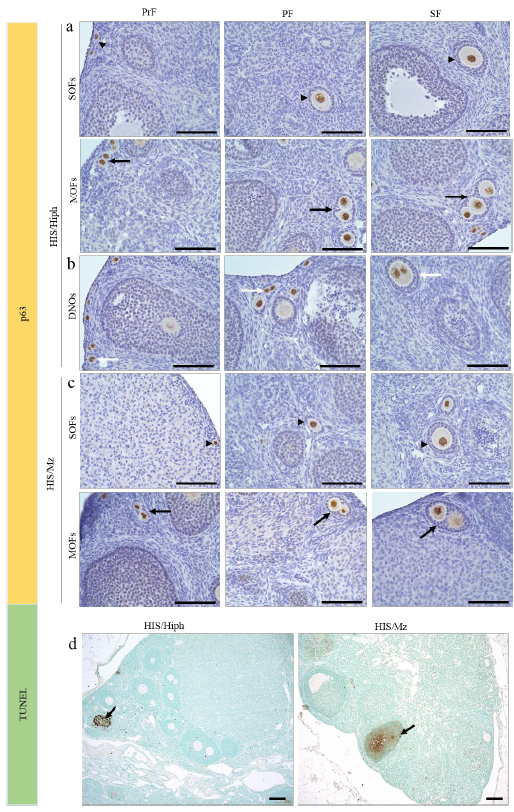
Figure 6. Evaluation of oocyte death in the ovaries of HIS/Hiph and HIS/Mz. ( a – c ) Immunohisto- chemistry for p63. Single-oocyte follicles (SOFs) classified as primordial (PrF), primary (PF), and secondary (SF) follicles (arrowheads), as well as multi-oocyte follicles (MOFs) (arrows) and double- nucleated oocytes (DNOs) (white arrows, found only in HIS/Hiph), containing p63-positive oocytes in 4-week-old HIS/Hiph ( a , b ) and HIS/Mz ( c ). ( d ) TUNEL assay. Panel shows lack of apoptotic oocytes, but granulosa cells (arrows) in the luteinized follicles show positive reactions in both strains. Scale bars = 100 µ m ( a – c ) or 200 µ m ( d